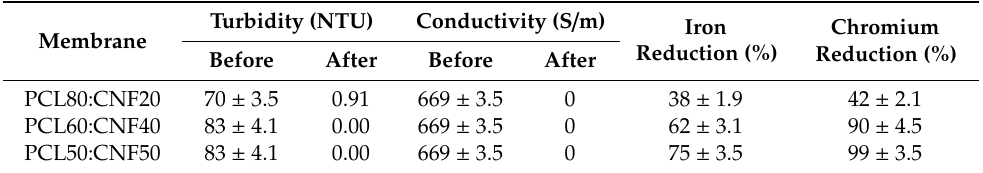
Table 2. Reduction of turbidity, conductivity, and heavy metal content (iron and chromium) in tap water before and after filtration.